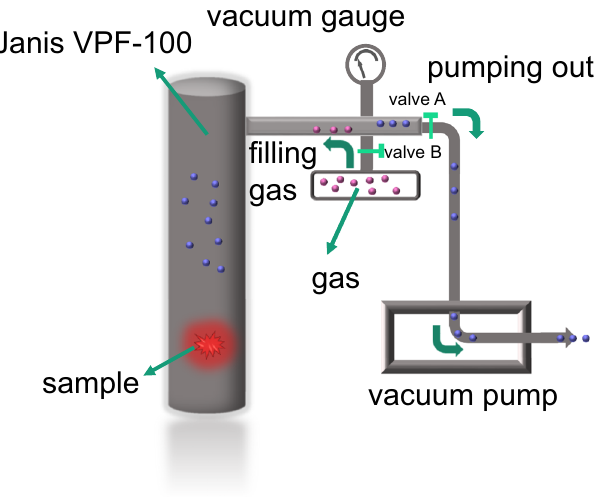
Fig. 3 The homemade system. The illustration of a homemade gas pressure detecting equipment adapted by Janis